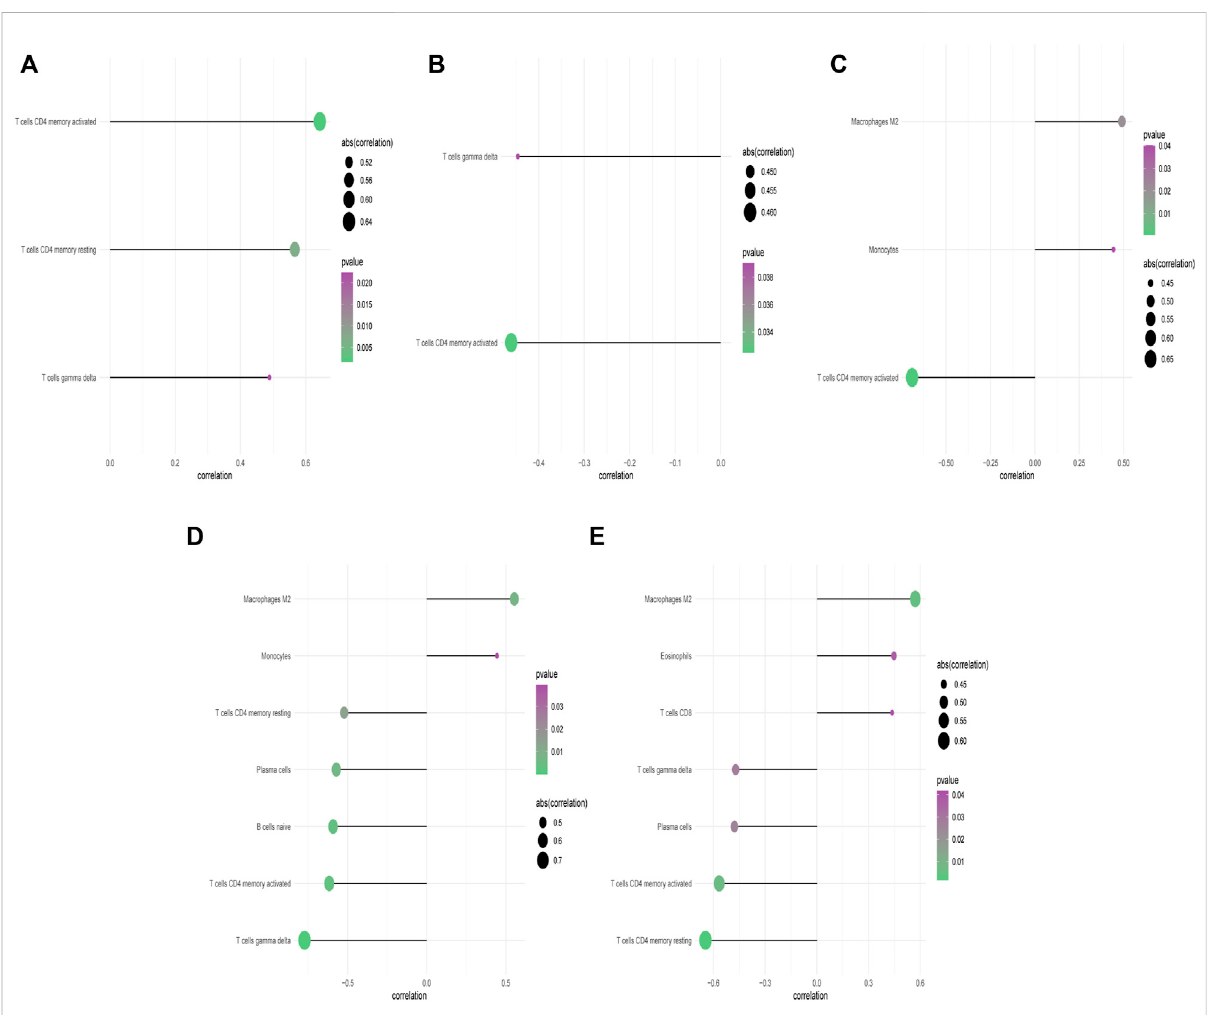
FIGURE 5 Correlation between CBLN1 , DNAH5 , HMOX1 , SLC26A8 , LOC100507250 and in fi ltrating immune cells. (A) Correlation between CBLN1 and in fi ltrating immune cells. (B) Correlation between LOC100507250 and in fi ltrating immune cells. (C) Correlation between DNAH5 and in fi ltrating immune cells. (D) Correlation between HMOX1 and in fi ltrating immune cells. (E) Correlation between SLC26A8 and in fi ltrating immune